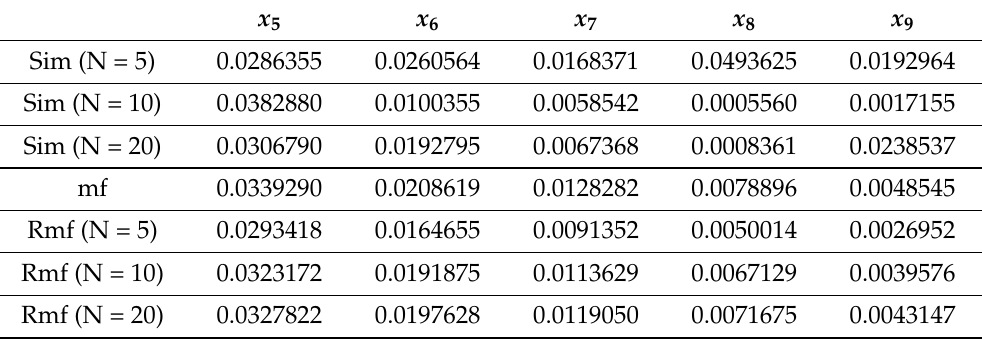
Table 3. Accuracy of mean-field approximation (mf) and refined mean-field approximation (rmf) when N = 5, 10, 20 for x 5 , . . . , x 9 .